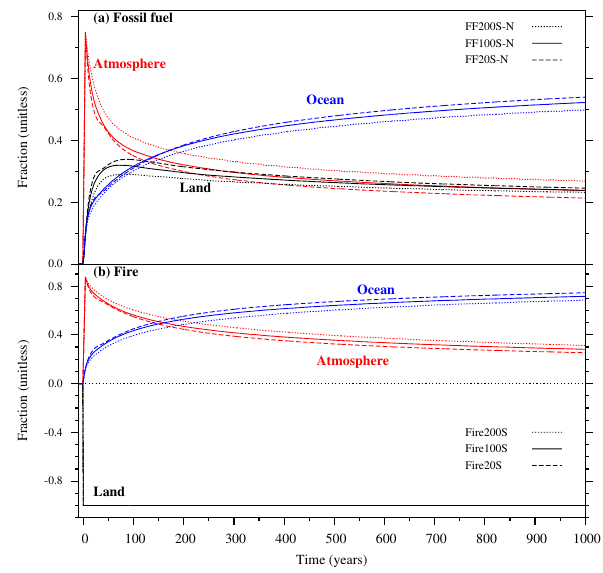
Figure 7. Changes in global carbon stocks resulting from the stable regime experiments. The changes are expressed as fractions of net cumulative emissions until the specific year considered. (a) Fossil fuel emissions, which were set equal to net yearly fire emissions. (b) Stable fire regimes; the onset of fire activity happened in year 0, after which fire frequency remained